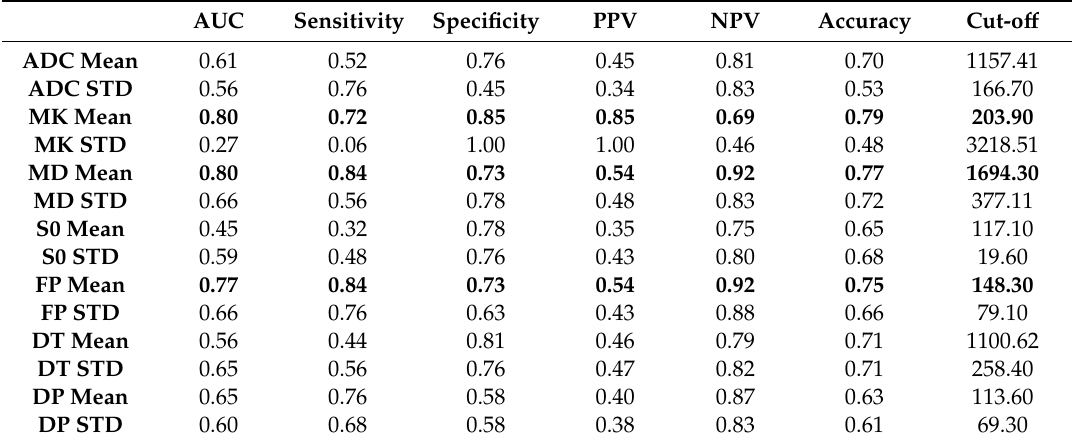
Table 4. Diagnostic performance of ADC-, IVIM- and DKI-derived parameters to detect RAS mutation. AUC Sensitivity Specificity PPV NPV Accuracy Cut-off ADC STD MK STD